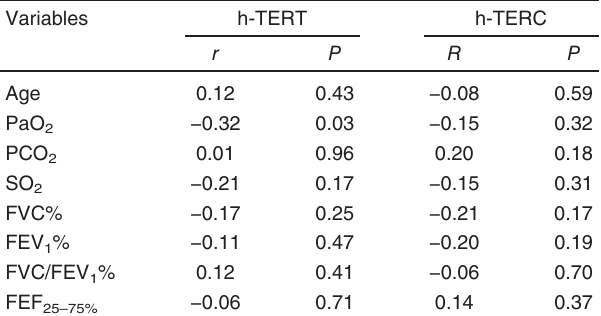
Table 3 Correlation between h-TERT and h-TERC and the characteristics of patients with interstitial lung disease Variables